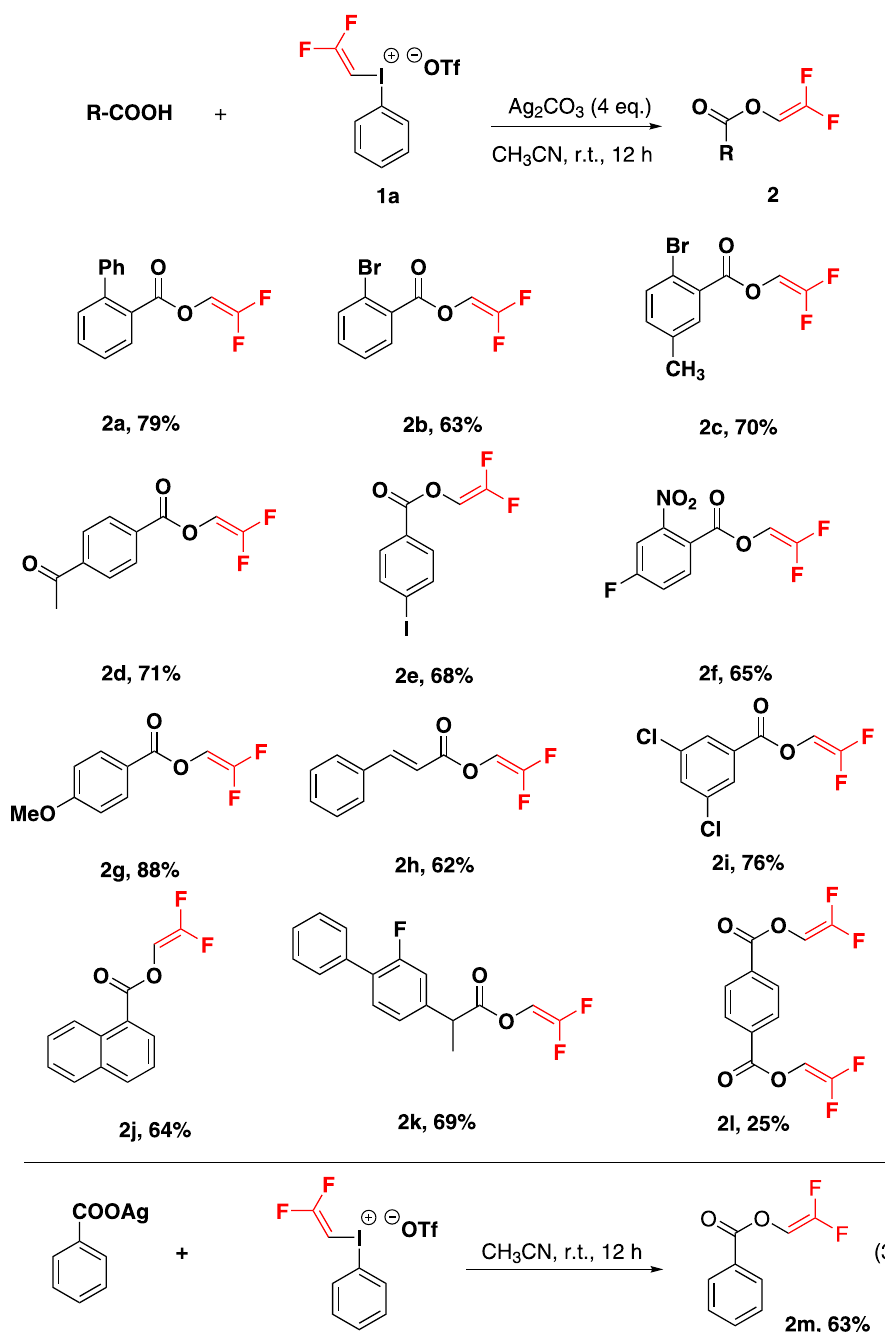
Fig. 4 Electrophilic gem-di fl uorovinylation of carboxylic acid. Reaction conditions: carboxylic acid (0.2 mmol), 1a (0.8 mmol), Ag 2 CO 3 (0.8 mmol) in CH 3 CN (2.0 ml) at room temperature for 12 h. Yields shown are of isolated